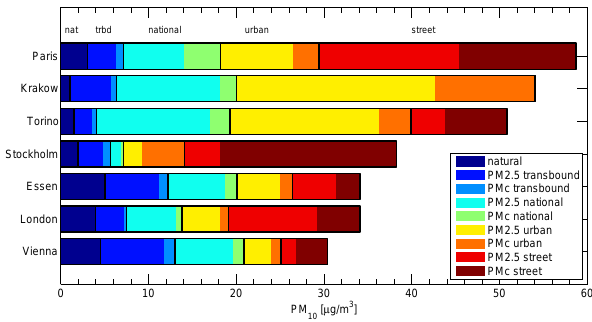
Figure 7. Modelled composition of PM 10 at seven monitoring sta- tions with different characteristics in the year 2009: spatial source contributions. “nat”: natural, “trbd”: